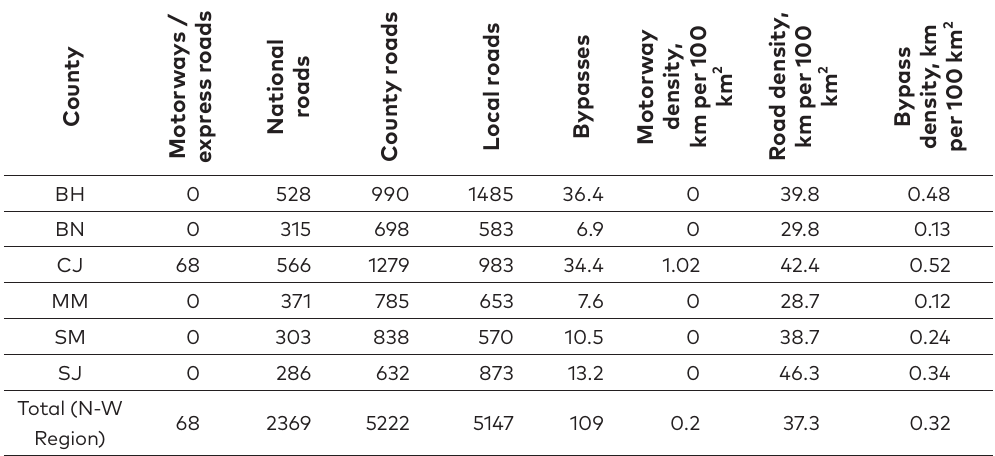
Table 2. Road network in the N-W Region of Romania (source: author*, 2018)